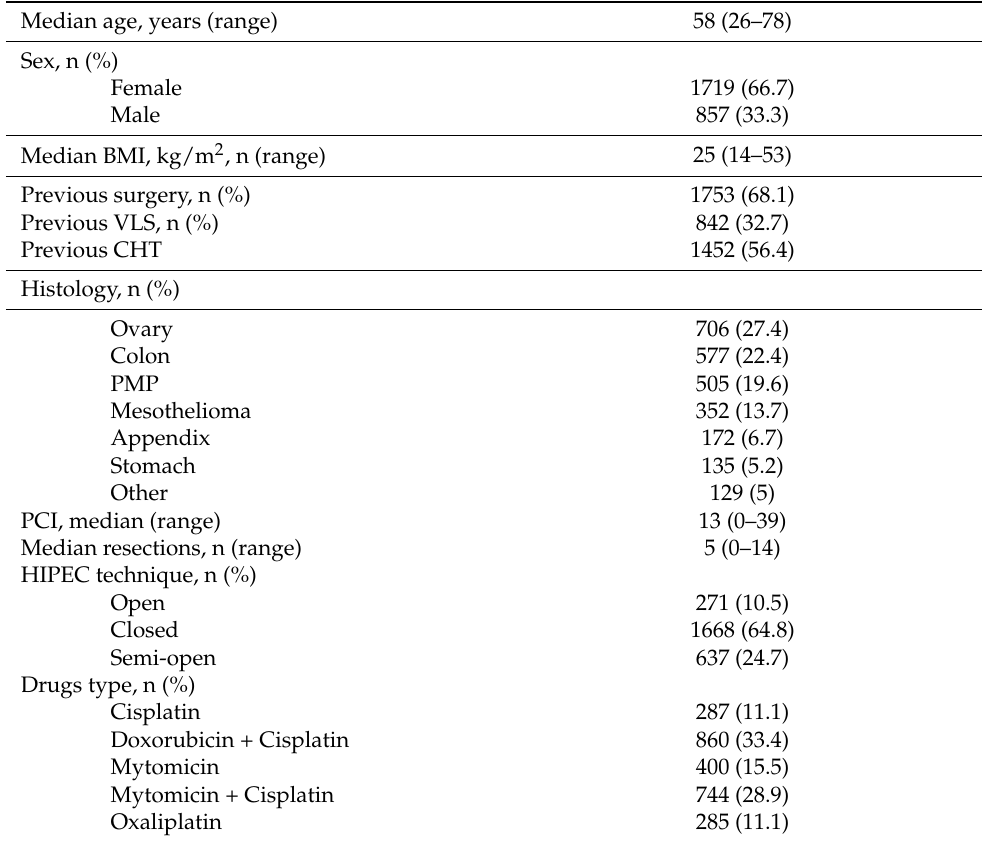
Table 2. Baseline and perioperative features (total 2576 patients).